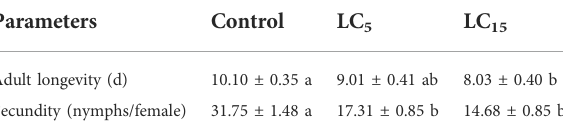
TABLE 2 Effect of exposure of parent adults (F 0 generation) of Brevicoryne brassicae to Spirotetramat at LC longevity and fecundity (Mean ± SE).